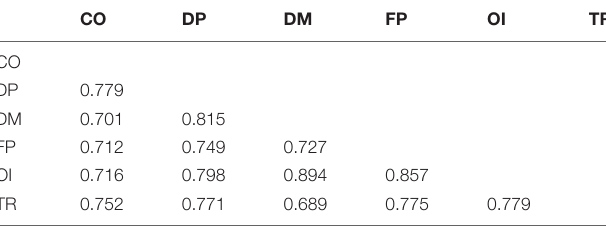
TABLE 2 | Discriminant validity (HTMT).